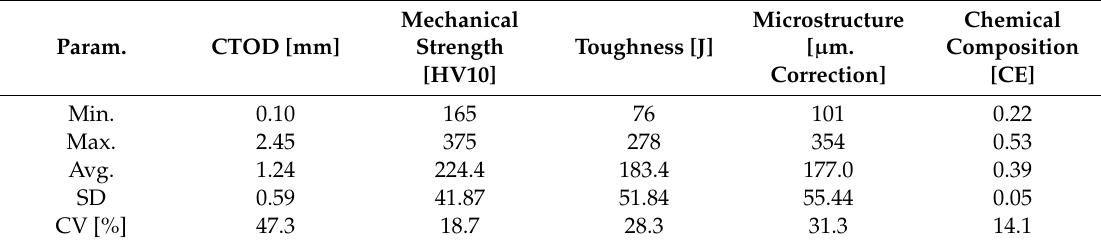
Table 3. Experimental phase results